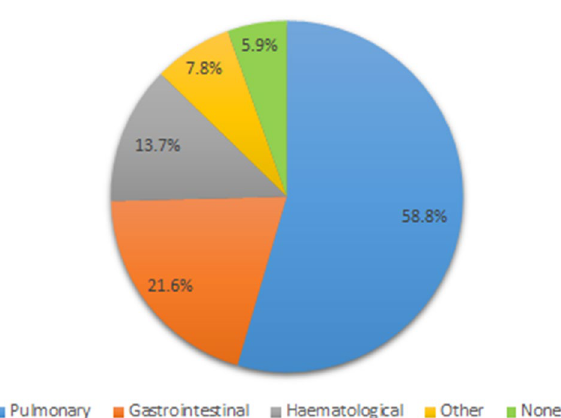
Figure 2. Toxicity, participants are most frequently concerned about under thoracic radioimmunotherapy (RT + ICI). Data is given in percent of all participants (N = 51). 4 (7.8%) out of 51 participants chose multiple answers. These are not depicted within the